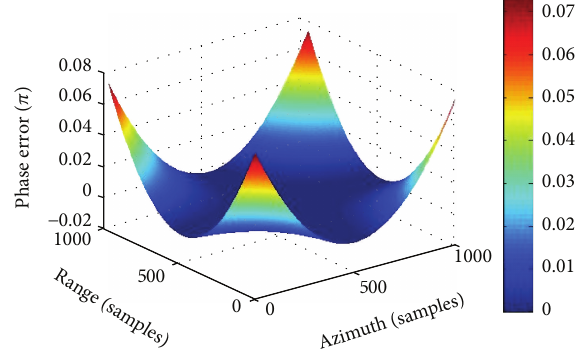
Figure 7: Phase error of the transformed